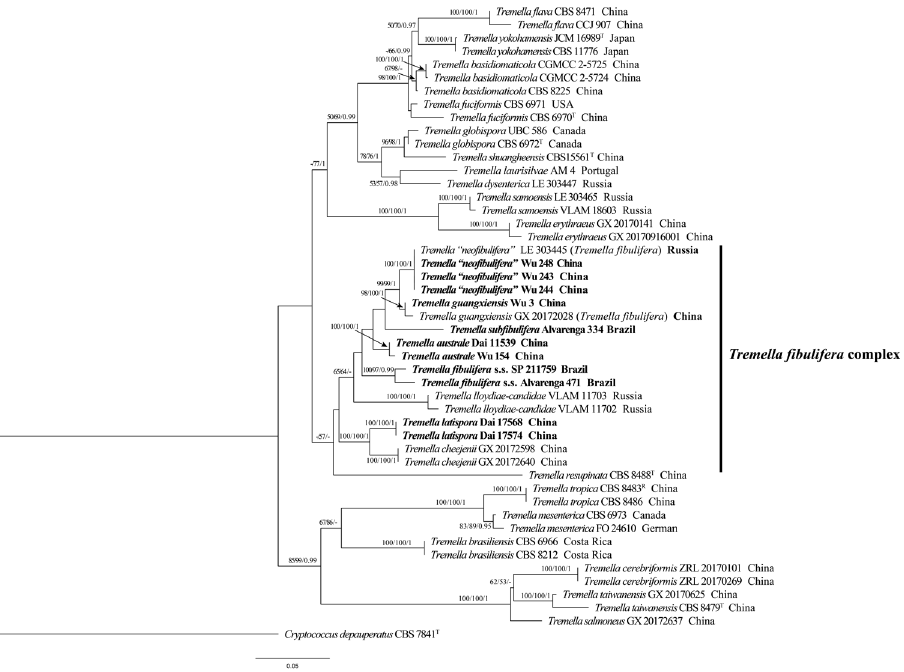
Figure 1. The Maximum likelihood tree showing phylogenetic relationship of species in Tremella s.s. based on the ITS + partial nLSU dataset. Bootstrap support values for MP and ML greater than 50% and BI greater than 0.95 are given at each node respectively. The samples used in this study are in